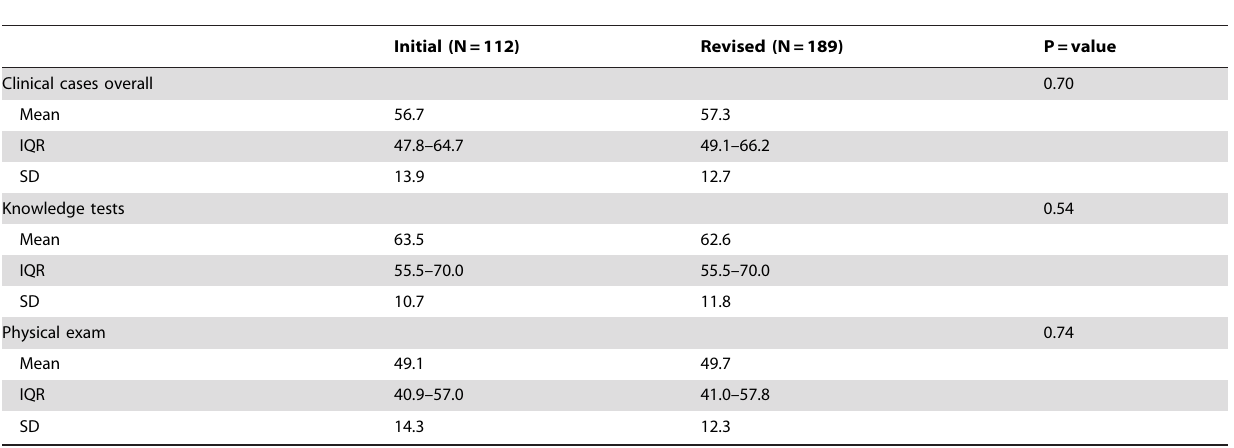
Table 3. Comparison of mean assessment scores* between TMGs in Initial vs. Revised curriculum at